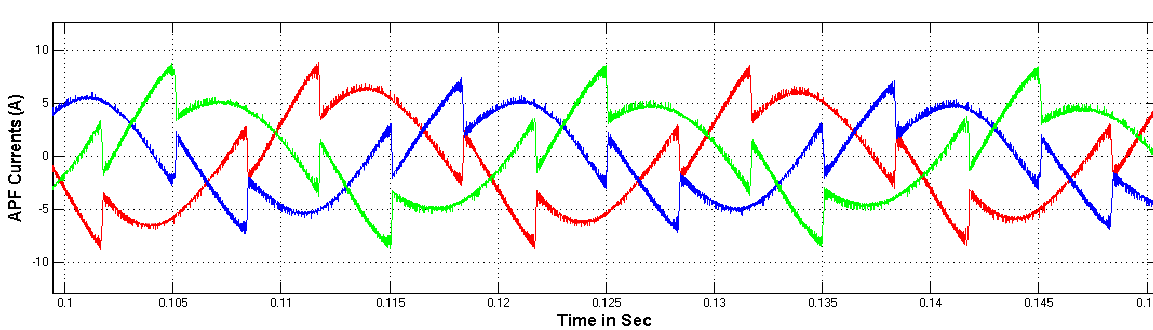
Figure 11. Filter Compensating currents from APF